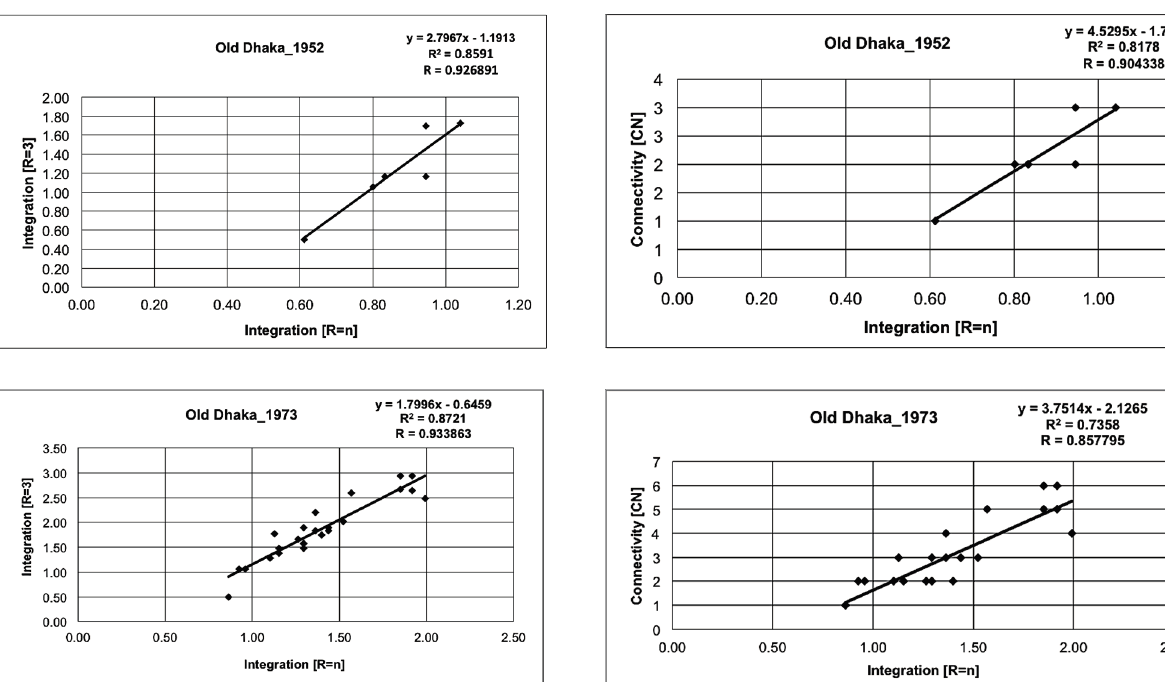
Figure 12. Scatter of correlation between local and global measures (R n -R3) and (R n -CN) of ward 72 (Old